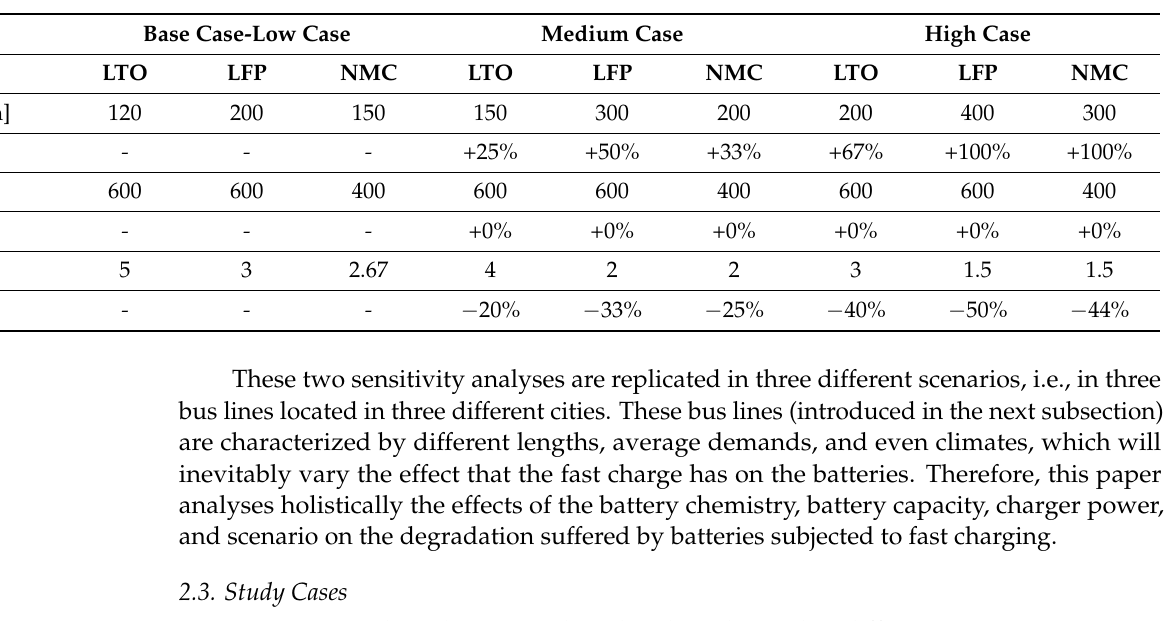
Table 7. Sensitivity analysis in relation to battery